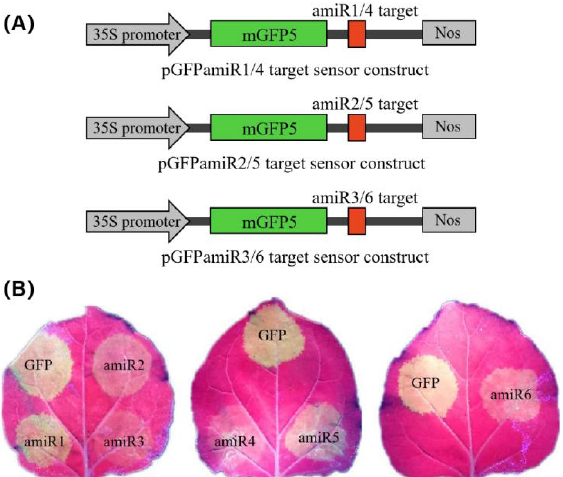
Figure 4. amiRNA functional assays for detecting transient co ‐ expression of amiRNAs and amiR ‐ GFP sensors. ( A ) Schematic representation of three pGFPamiR target sensor constructs, each containing two (amiR1 and amiR4, amiR2 and amiR5, amiR3 and amiR6) amiRNA target sites in the 3 ′ untranslated region of the mGFP5 reporter gene, under the control of the cauliflower mosaic virus 35S promoter. ( B ) Biological activity of amiRNAs in transient co ‐ infiltration assays. The pGFPamiR target sensor constructs were co ‐ infiltrated with the corresponding amiRNA constructs into Nicotiana benthamiana leaves. As a control, the original pEG100 ‐ miR171 and either of the pGFPamiR sensor constructs were co ‐ infiltrated. The reduced GFP fluorescence indicates target cleavage by the biological activity of the individual amiRNAs, whereas bright fluorescence indicates the disabled function of the amiRNAs. The three biological repeats of the transient assays showed similar results. GFP, green fluorescent protein.